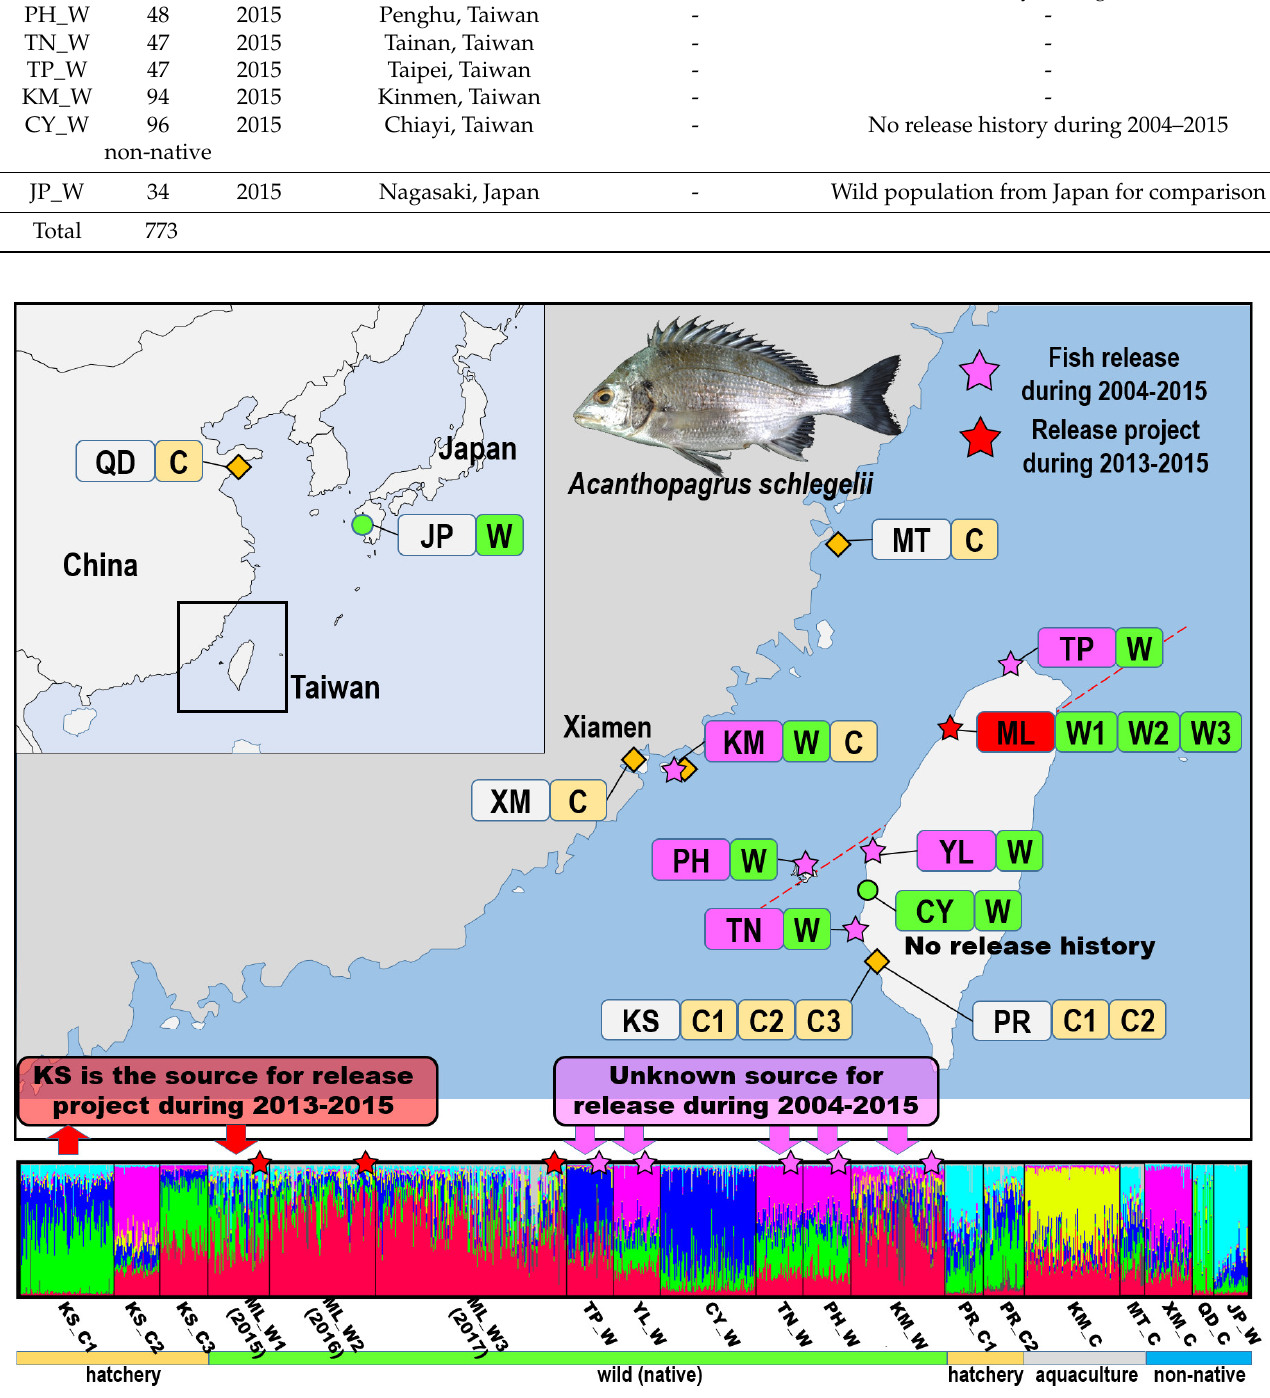
Figure 2. Sampling locations and structure analysis of 19 black sea bream populations. KS: